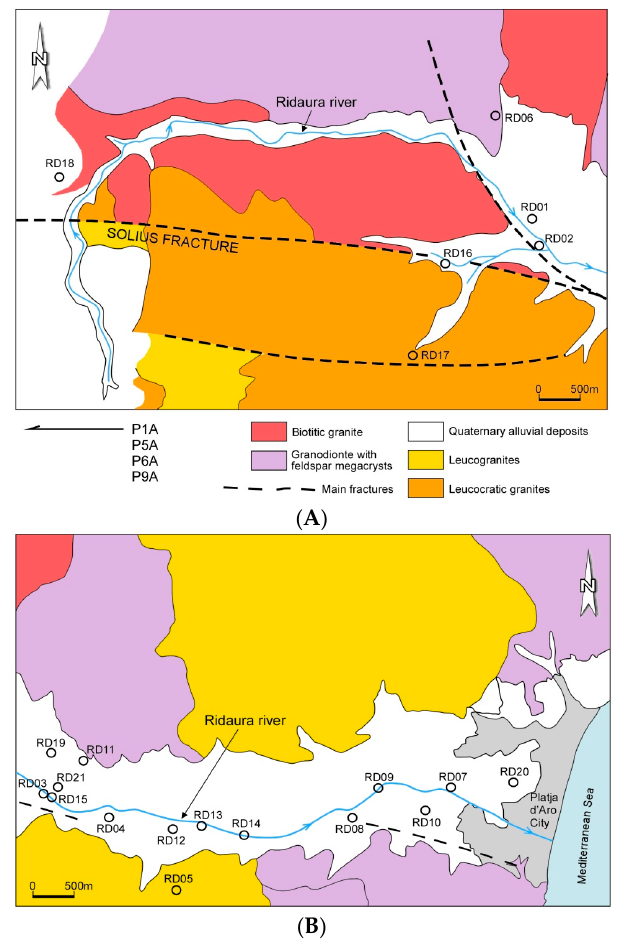
Figure 2. Synthetic geological map and water samples location. ( A ) Western area of Ridaura basin; ( B ) Eastern area of Ridaura basin.